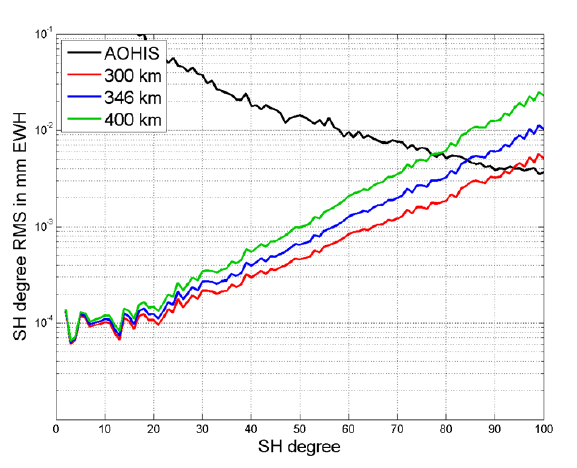
Fig. 3. Residual errors of monthly gravity field recovery compared to simulated signal (black curve) including only instrument errors, showing the impact of orbit height for MOBILE baseline configura- tion. The blue curve is equivalent to Figure 5.